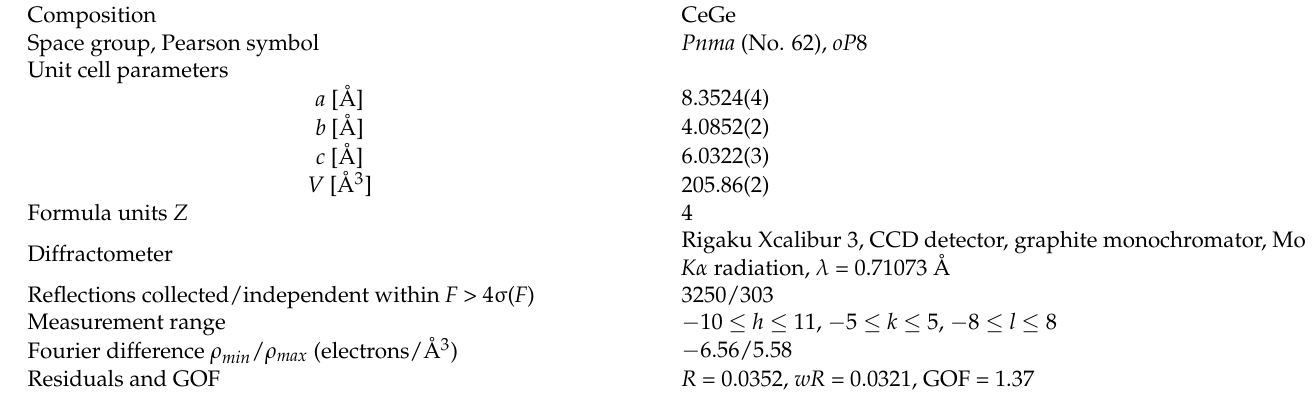
Table 3. X-ray diffraction data for CeGe. Further details on the crystal structure investigations can be